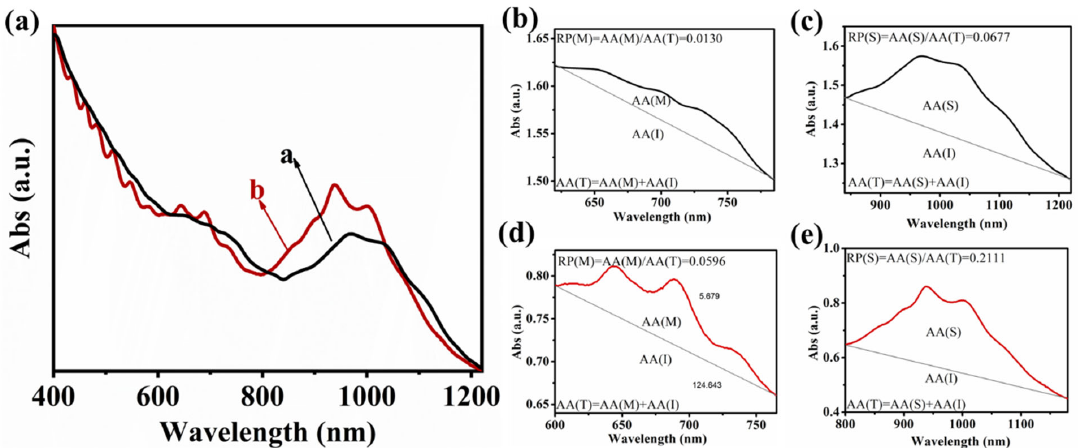
Figure 3. ( a ) Normalized Vis–NIR absorption spectra of primarily purified SWNTs (line a) and BA–PMS dispersed SWNTs (line b) and ( b – e ) the relative abundance of m–SWNTs and sc–SWNTs. Raman spectroscopy plays an essential role in the characterization of carbon materi ‐ als. Especially, the radial breathing mode (RBM) in the range of 100–300 cm − 1 and the tan ‐ gential Raman mode (G band) near 1590 cm − 1 are the fingerprints of SWNTs. Shown in Figure 4 are the Raman spectra of the primarily purified and the BA–PMS dispersed SWNTs. In the RBM range, we note that all of the RBM peaks of the BA–PMS dispersed SWNTs are systematically blue–shifted in comparison with those of the primarily purified ones, regardless of their relative intensities. For example, the peaks at 163 and 149 cm − 1 for the primarily purified SWNTs are blue–shifted to 175 and 166 cm − 1 for the BA–PMS dis ‐ persed SWNTs in the 458 and 633 nm excitation spectra, respectively. We observed previ ‐ ously a similar blue shift in the RBM frequency for the well–dispersed SWNTs relative to those before dispersion [39,40], which is a direct result of unbundling–induced blue shift for the electronic transition, making it possible for SWNTs with different diameters in a bundle or individual states to resonate with the same laser excitation. On the other hand, because of the curvature of the rolled–up graphite sheet, the G band of SWNTs splits to the higher frequency component (G + ) attributed to vibrations along the direction of the nanotube axis and the lower frequency component (G − ) associated with vibrations along the circumferential direction. It can be observed from Figure 4 that the upper sharp G + bands narrow down when the primarily purified SWNTs are dispersed in the aqueous solution of BA–PMS. Both the blue–shifted RBM band and the narrowed G + band ob ‐ served in Figure 4 are ascribed to the efficient unbundling and effective individualization of the BA–PMS dispersed SWNTs. Moreover, for the arc–discharged SWNTs, metallic and